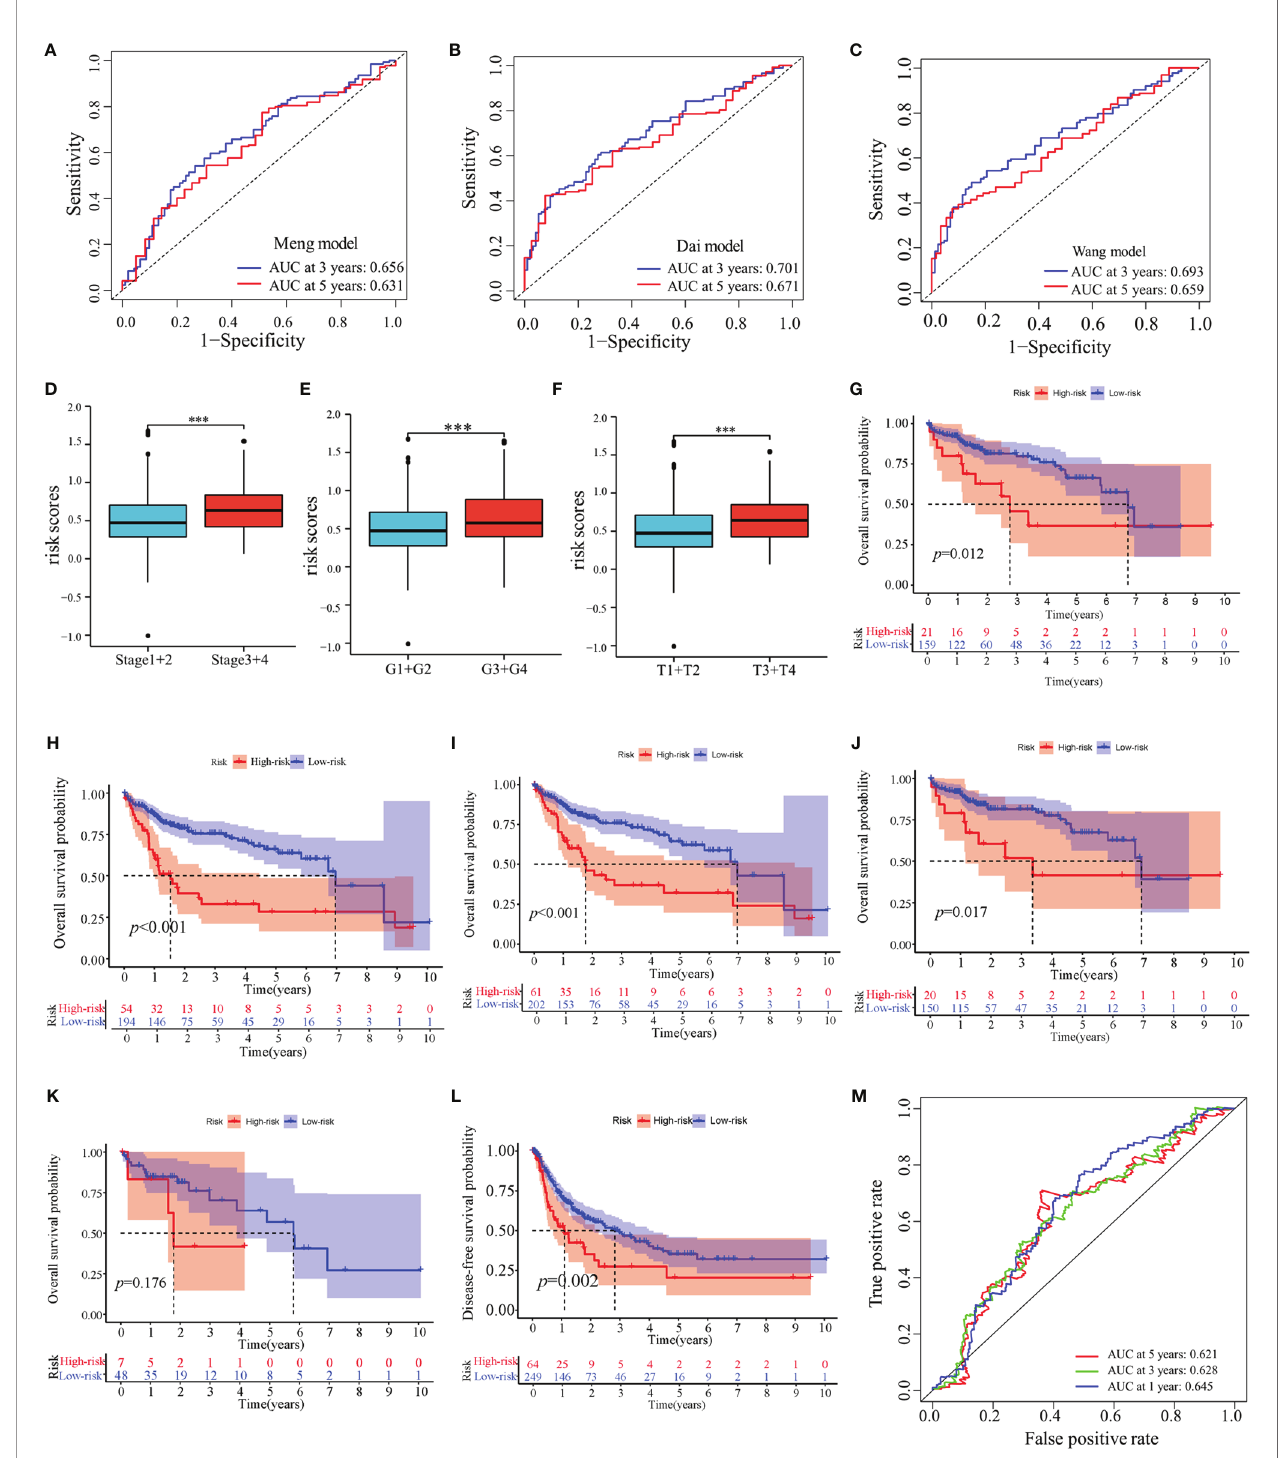
FIGURE 4 | Prognostic values of the predictive model in TCGA-LIHC cohort. (A – C) ROC analyses of the other published immune-related models. (D – F) Distribution of risk scores in pathological stage (D) , histological grade (E) and T stage (F) of TCGA-LIHC cohort. (G – K) Overall survival analyses between low-risk and high-risk subgroups in T1 stage (G) , N0 stage (H) , M0 stage (I) , pathological stage 1 (J) and histological grade 1 (K) . (L) Disease-free survival analysis in high-risk and low- risk groups of TCGA-LIHC cohort. (M) ROC analyses of disease-free survival in TCGA-LIHC cohort. ***: P <